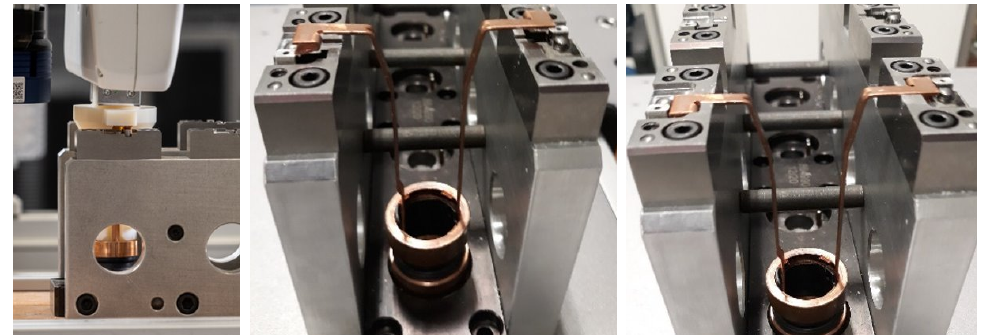
Figure 5. Left: Insertion of the ring into a modeling fixture. Center: Incorrect insertion. Right: Correct